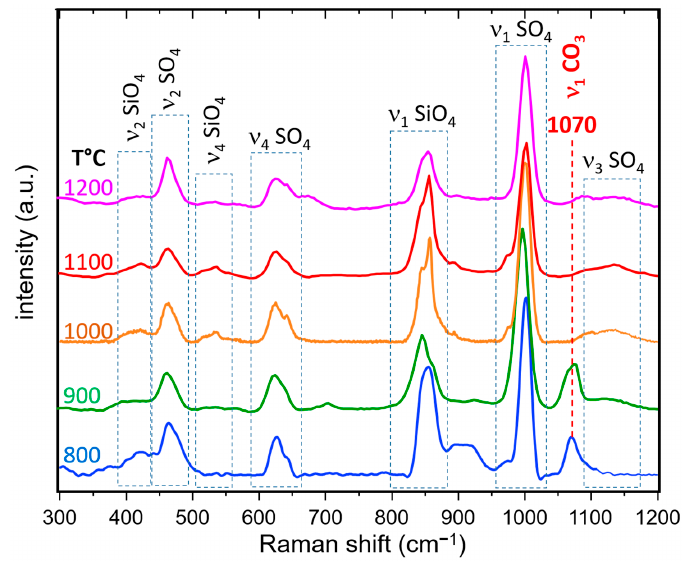
Figure 6. Raman spectra of SCE D2 samples calcined at temperatures 800, 900, 1000, and 1100 ◦ C (from bottom to top) In addition, the Raman spectrum of SCE obtained from calcination of the P sample at 1200 ◦ C is shown (top). Samples 800 and 900 ◦ C proof CO 3 groups in the ellestadite